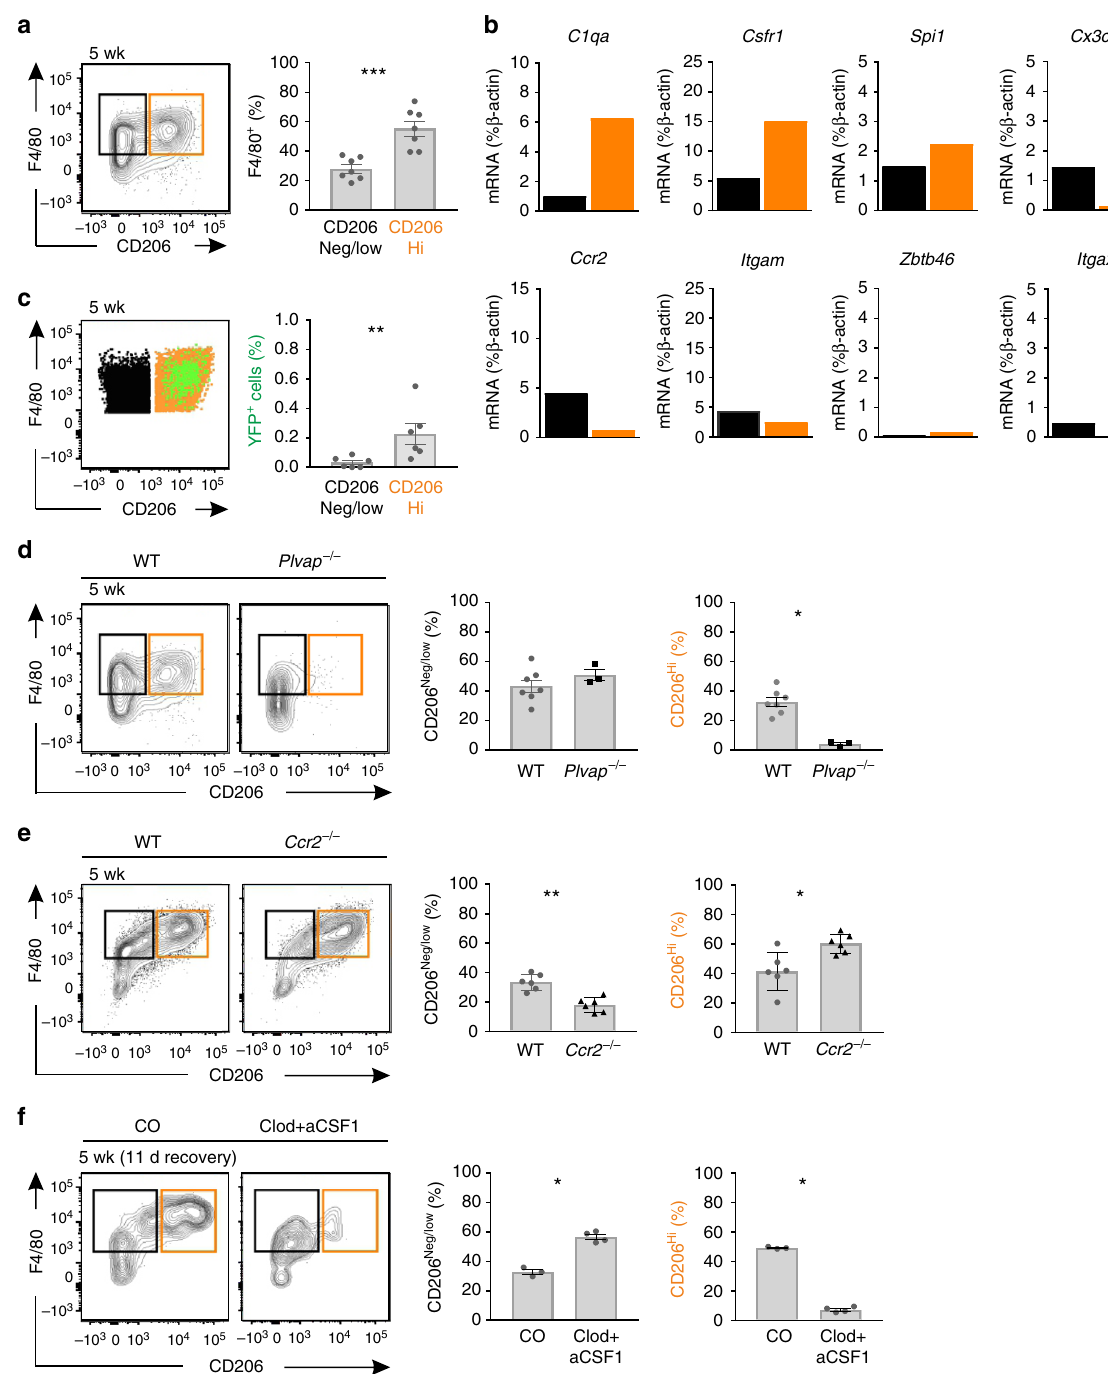
Fig. 4 CD206 Hi leukocytes represent fetal-derived macrophages in adult mammary glands. a Fluorimetric fl ow analyses of 5 wk old wild type (WT) mammary gland (MG) macrophages for F4/80 and CD206. b qPCR analysis of the indicated transcripts in CD206 Neg/low and CD206 Hi MG macrophage populations sorted from 5 wk old WT mice. The sorted populations were pooled from fi ve donors, and the mRNA expression values are shown in relation to a control gene β -actin. c Analyses of CD206 Neg/low and CD206 Hi MG macrophages from 5 wk old CX3CR1-YFP reporter mice (tamoxifen induction at E13.5). The representative FACS plot shows backgating of the YFP + cells (green) onto CD206 Neg/low (black) and CD206 Hi (orange) cells, and the quanti fi cation shows the frequency of YFP + cells in these two macrophage populations. d Fluorimetric analyses of CD206 Neg/low and CD206 Hi MG macrophages in 5 wk old WT and Plvap − / − mice. e CD206 Neg/low and CD206 Hi MG macrophages in 5 wk old WT and Ccr2 − / − mice. f CD206 Neg/low and CD206 Hi MG macrophages in control (CO) and clodronate-anti-CSF1 (Clod + aCSF1) treated mice at 5 wk (after an 11 day recovery period). In all panels ( a – f ) MG macrophages were de fi ned as CD45 + CD11b + Siglec-F − F4/80 + cells, and CD206 Neg/low cells have been gated in black and CD206 Hi cells in orange. In the quanti fi cations, each dot represents one mouse and mean ± SEM are shown. Data are from 3 ( a ), and 2 ( b (for sortings), c – f ) independent experiments. * p < 0.05, ** p < 0.01, *** p < 0.001 (Kruskal – Wallis test). Source data are provided as a Source Data fi le